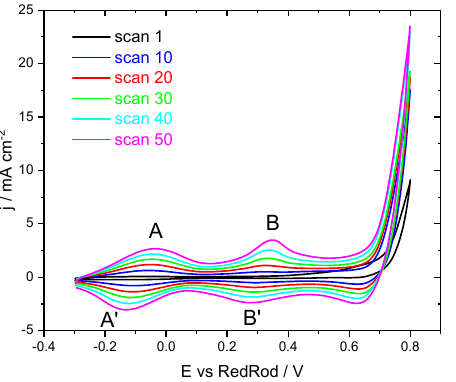
Figure 2. Cyclic voltammograms of IrOx growth with a scan rate of 50 mV/s.